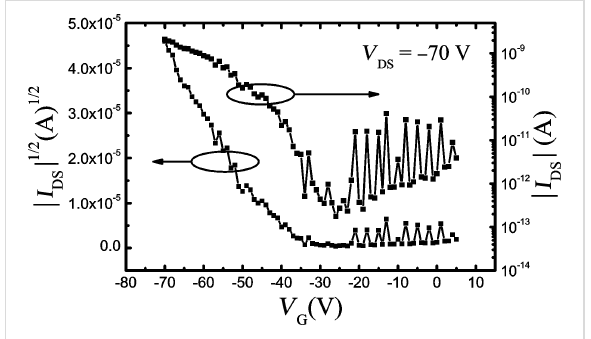
Figure 5: Transfer curve of the Al(Op) 3 -based TFT with a channel length of 100 μ m. In this figure, I DS and V DS are the source–drain current and voltage and V G refers to the gate voltage. The hole mobility, extrapolated by the transfer characteristics, ranges between